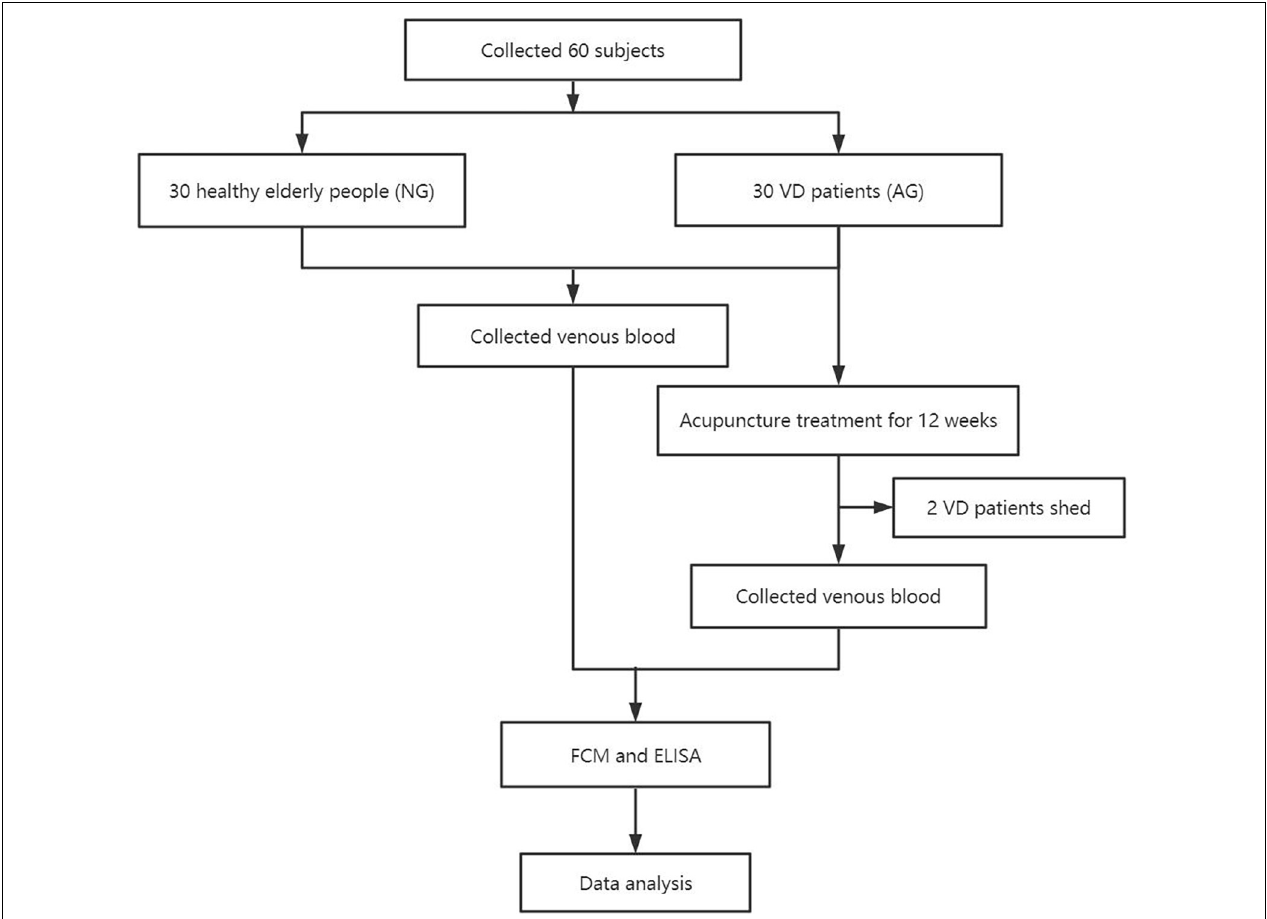
FIGURE 1 | Research